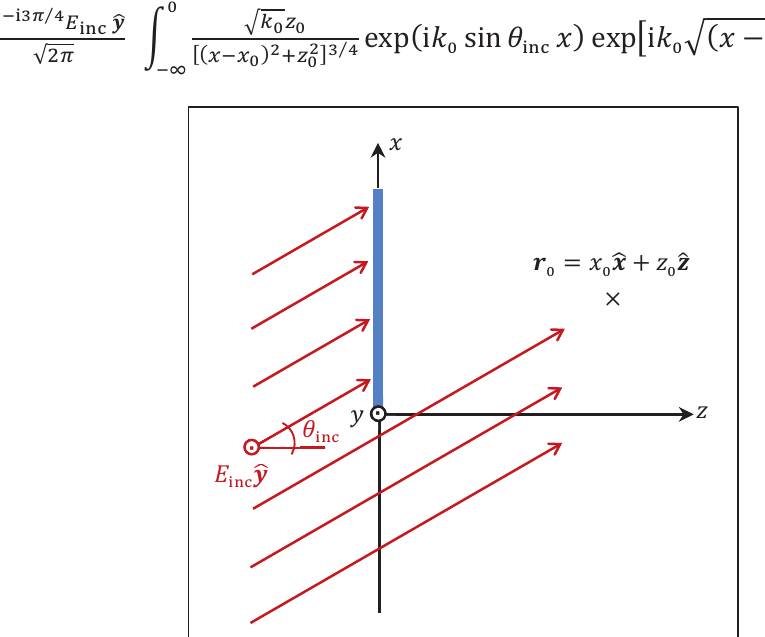
Fig.2 . A perfectly conducting thin sheet sits in the upper half of the (cid:1876)(cid:1877) -plane at (cid:1878) = 0 . The incident plane- wave, which is linearly polarized along the (cid:1877) -axis, has amplitude (cid:1831) and propagation direction (cid:2252)